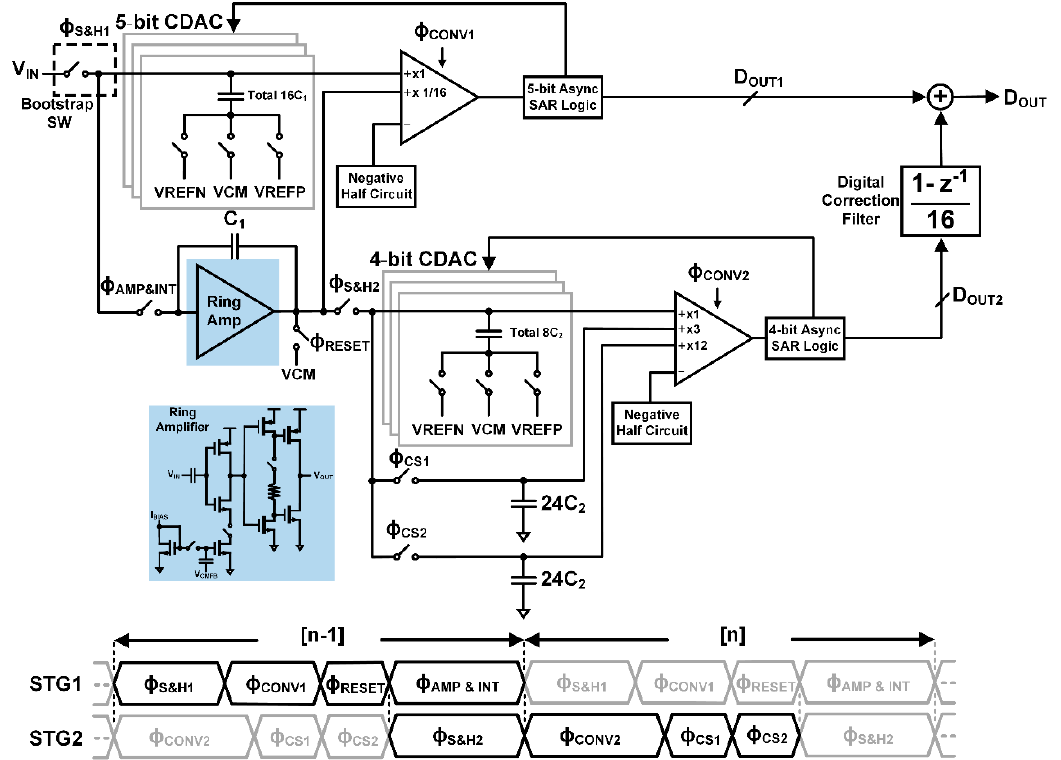
Figure 10. The circuit implementation of the proposed ADC and its operation timing diagram.